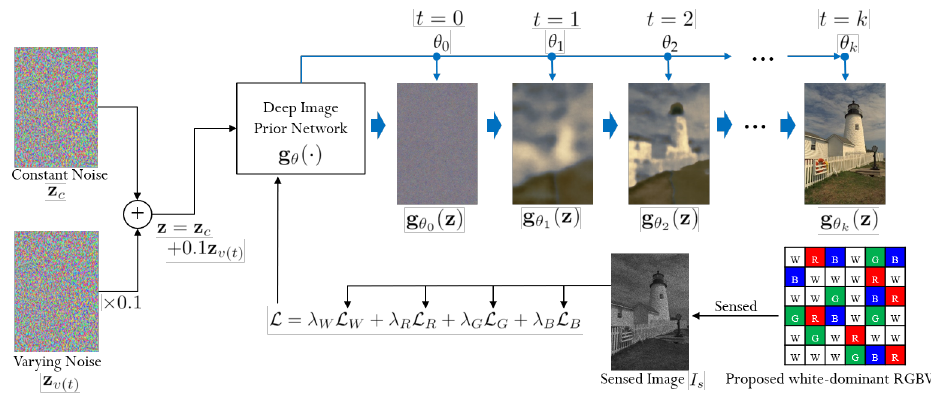
Figure 3. Overall diagram of the proposed